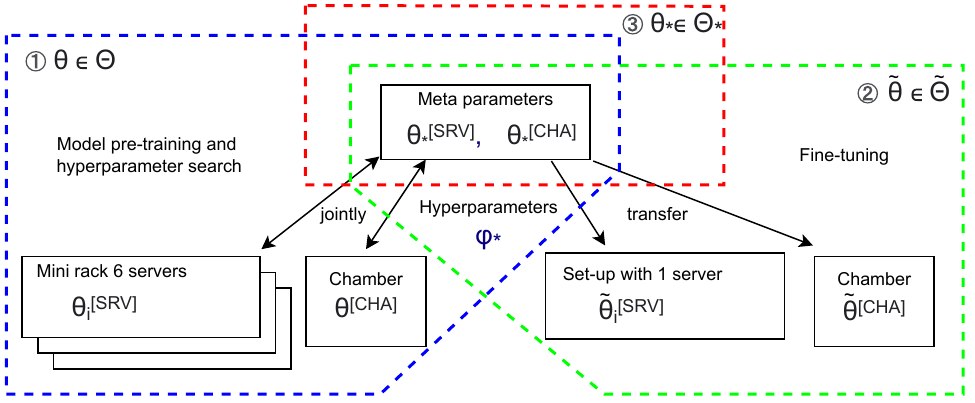
Figure 6. Conceptual illustration of the transfer learning procedure where in pre-training (1: blue area), the model for the six server set-up (with parameter set Θ ) and the meta parameter set Θ ∗ are first trained together. Transfer learning (2: green area) is then obtained when the single server model (with parameters in set ˜ Θ ) is fine-tuned under regularization by the meta parameters. Note that the meta parameters (3: red area) are updated in pre-training (indicated by two-way arrows) but remain fixed during fine-tuning (one-way arrows). Hyper-parameters φ are also